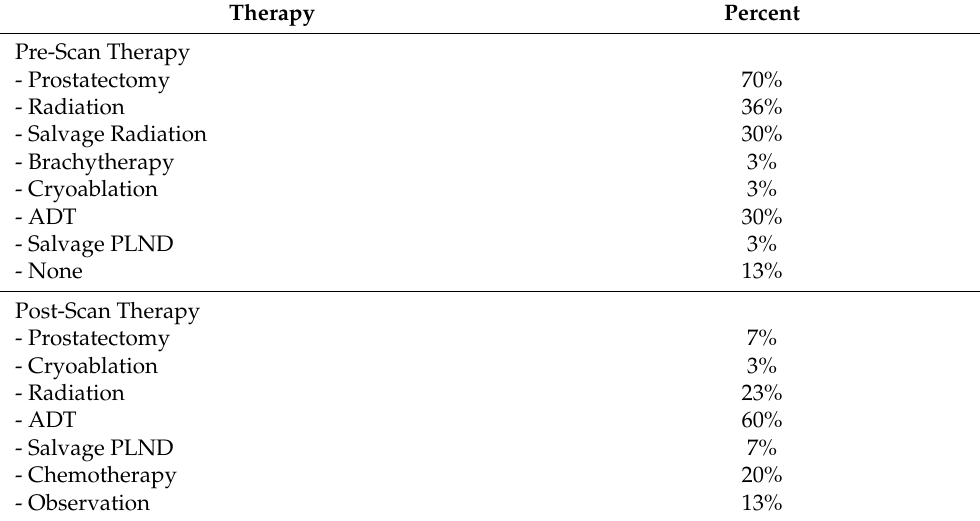
Table 1. Treatment data from patients included in this